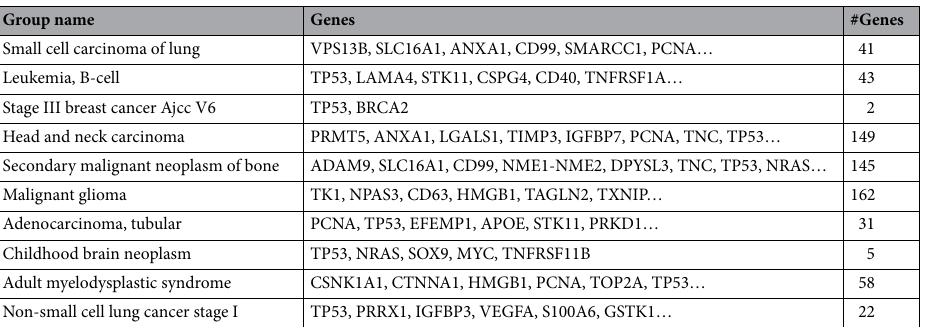
Table 2. An example of groups of diseases with their associated genes. The last column represents the number of genes in each group (group